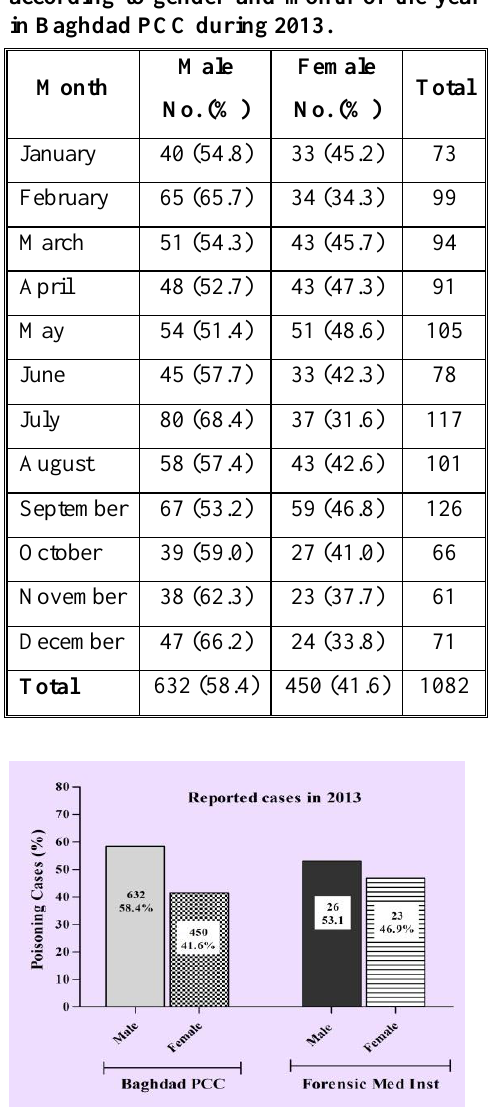
Figure (3): Gender distribution of poisoning cases reported in Baghdad PCC and Forensic Medicine Institute during 2013.